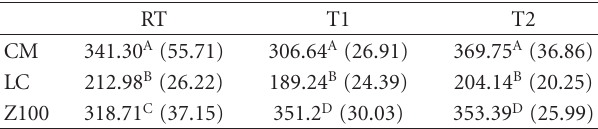
Table 3: Means and SDs of Compressive strength values for the three composite materials in MPa. Means with same superscript letter did not significantly di ff er statistically ( P > 0 . 05).